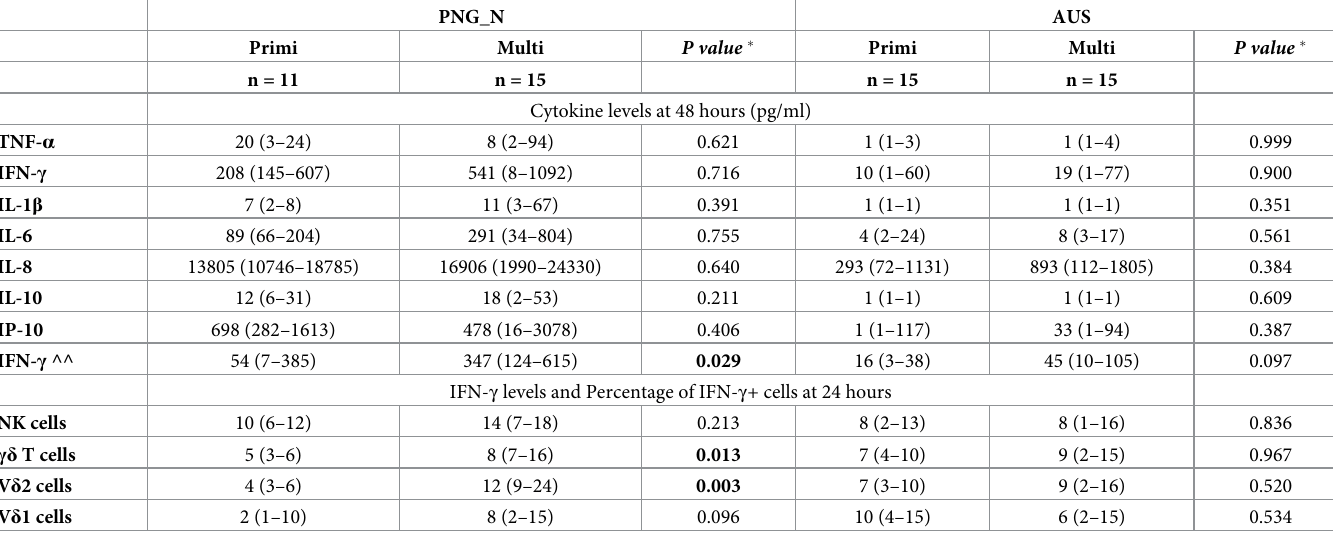
Table 4. Cytokine secretion and cellular responses to CS2 IE between primigravid and multigravid